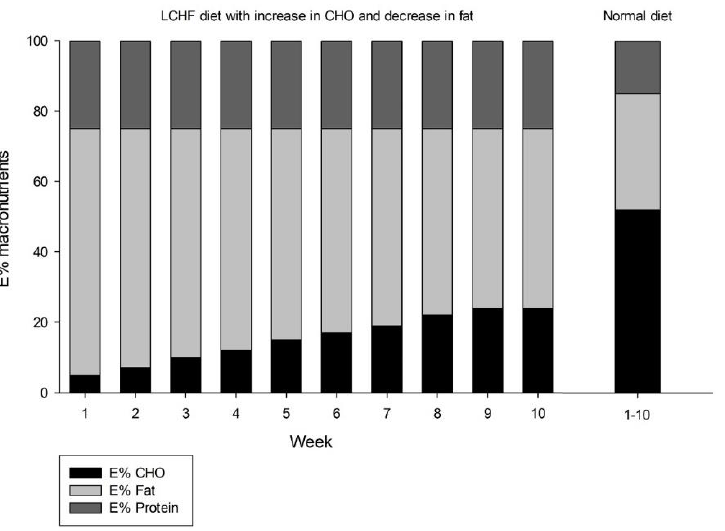
Figure 3. Target of E% of carbohydrates (CHO), fat and protein in the low-carbohydrate high-fat (LCHF) diet, and normal (NORM) diet (far right). In the LCHF groups, an increment of 10 g of carbohydrates was planned every week, until participants reached 100 g daily intake. A proportional decrease in kcal fat was planned alongside the carbohydrate increase, to keep kcal intake within protocol. The NORM diet was based on recommendations by the Norwegian Health Authorities and defined as normal diet for this study.